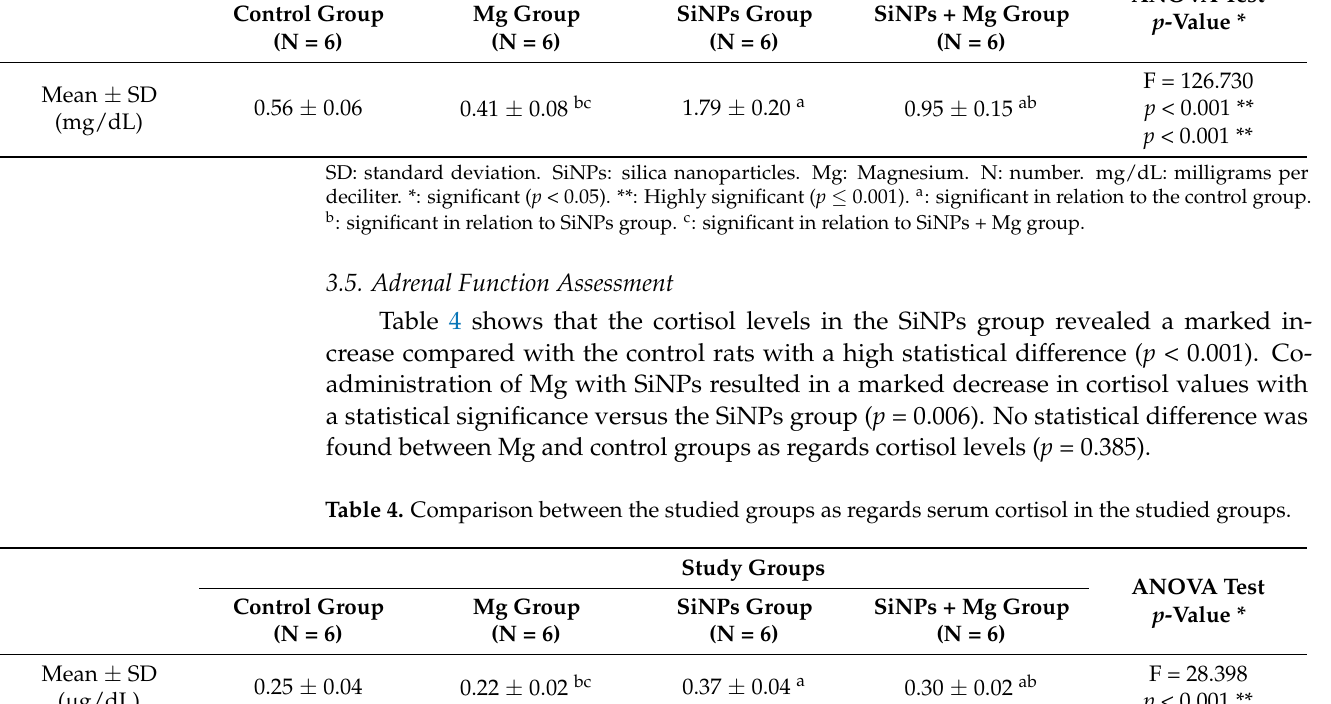
ANOVA Test p -Value *Control Group